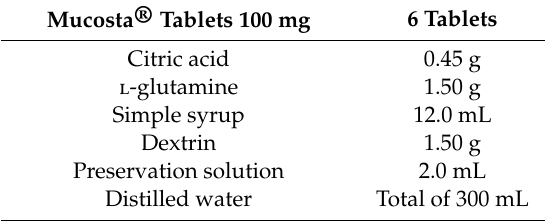
Table 1. Composition of rebamipide (RB) mouthwash at Kashiwa City Hospital.